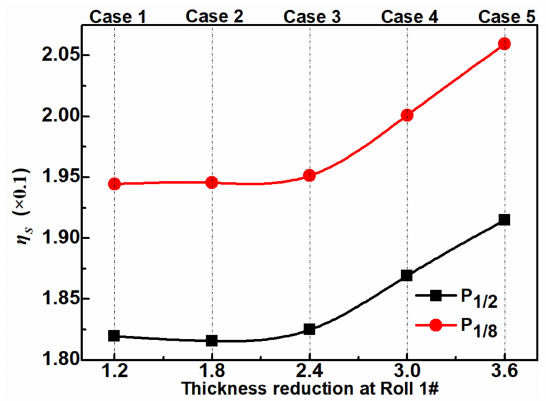
Figure 20. Porosity closure degree after HR in Case 1 to 5 ignoring the variation of the slab temperature field during HR.